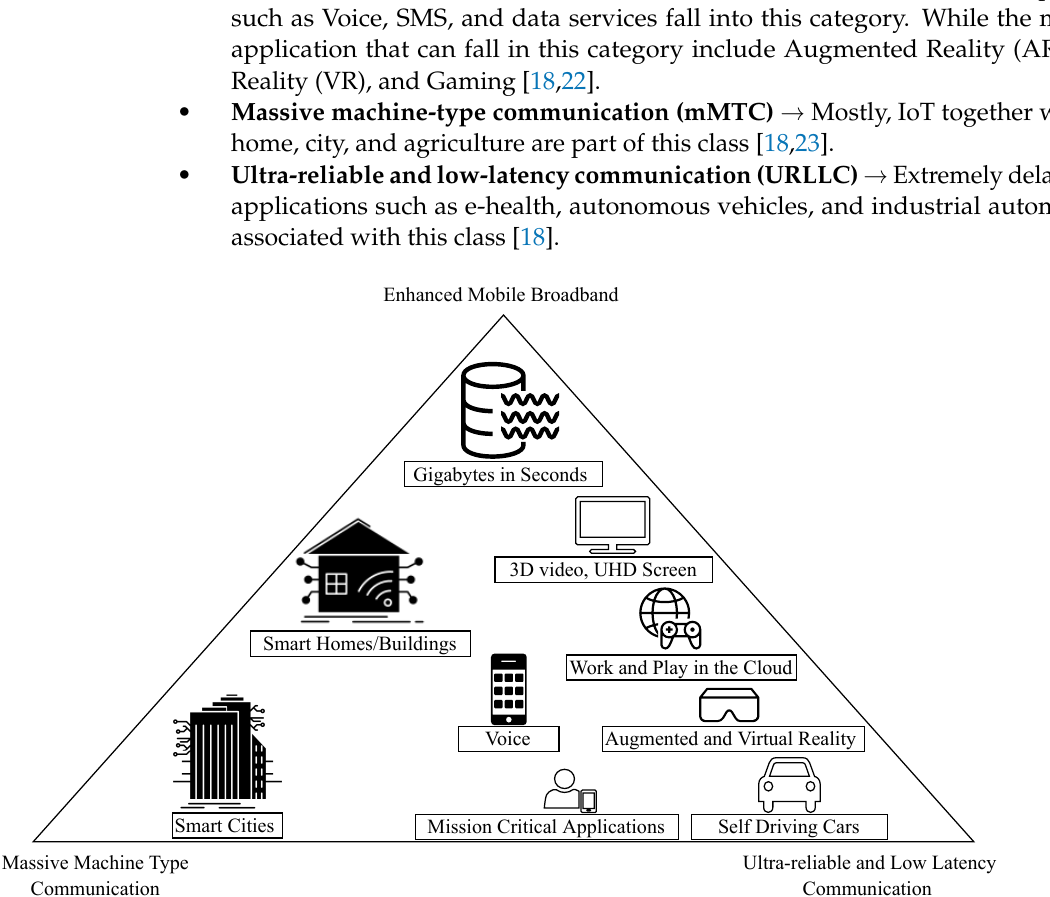
Figure 2. Applications and services in IMT-2020 (5G)